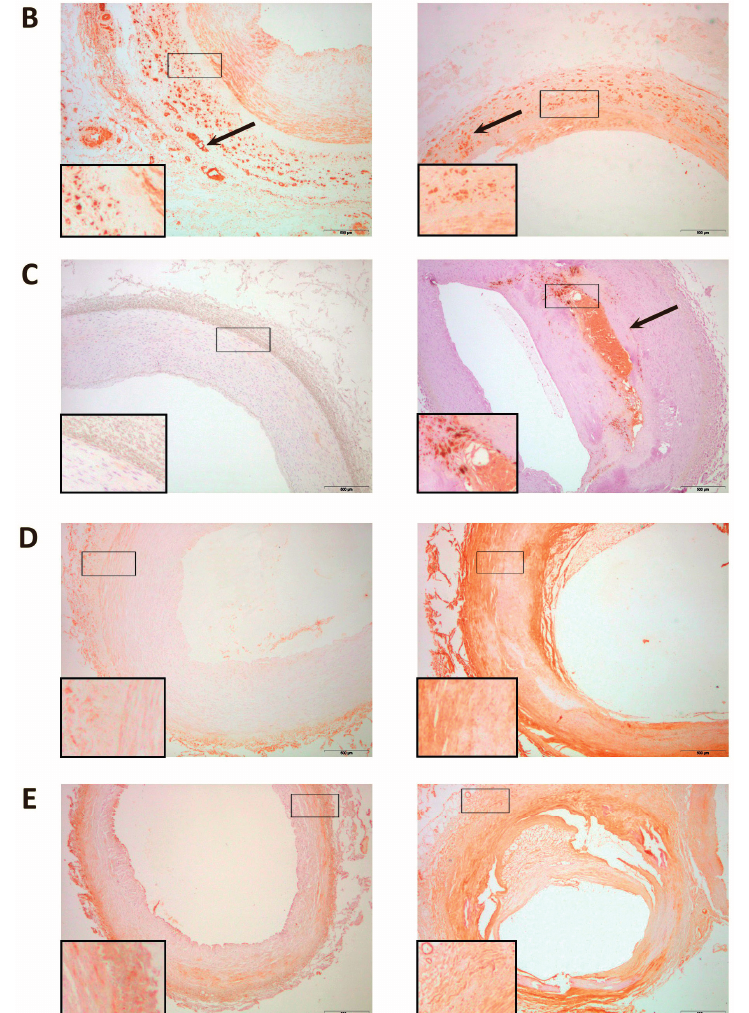
Figure 3. Representative immunohistochemical images for inflammatory markers in peripheral arteries: ( A ) Chemokine (C–C motif) ligand 2 (CCL2) was expressed in